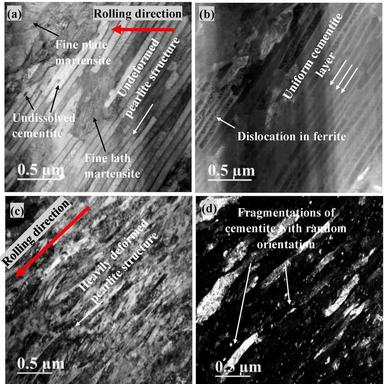
Bright and dark field TEM images showing the characterisation of the transition zone. (a) BF and (b) DF of rail sample A using cementite reflections; (c) BF and (d) DF of rail sample B using cementite reflections.